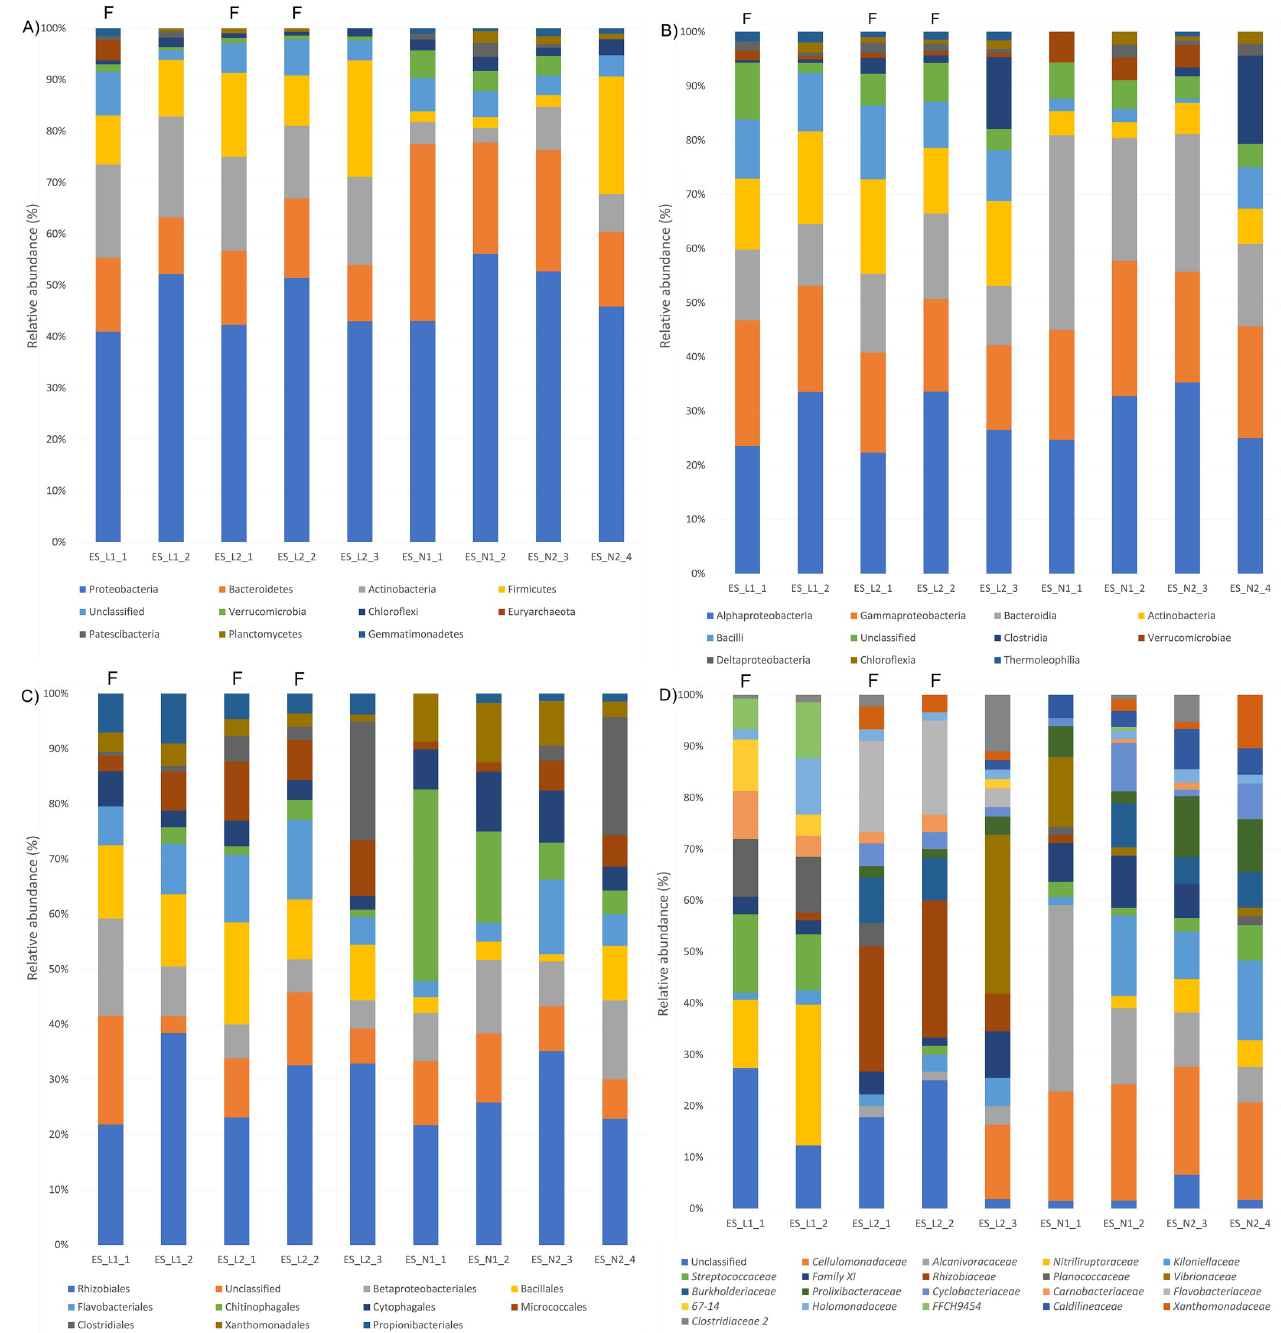
Fig 5. Percentage of the main 10 phyla (A), 10 classes (B), 10 orders (C) and 20 families (D) found in six samples of eggshells, collected from Linosa 2018 (indicated as ES_L1), Linosa 2019 (indicated as ES_L2), Ascea Marina (indicated as ES_N1) and Eboli (indicated as ES_N2)